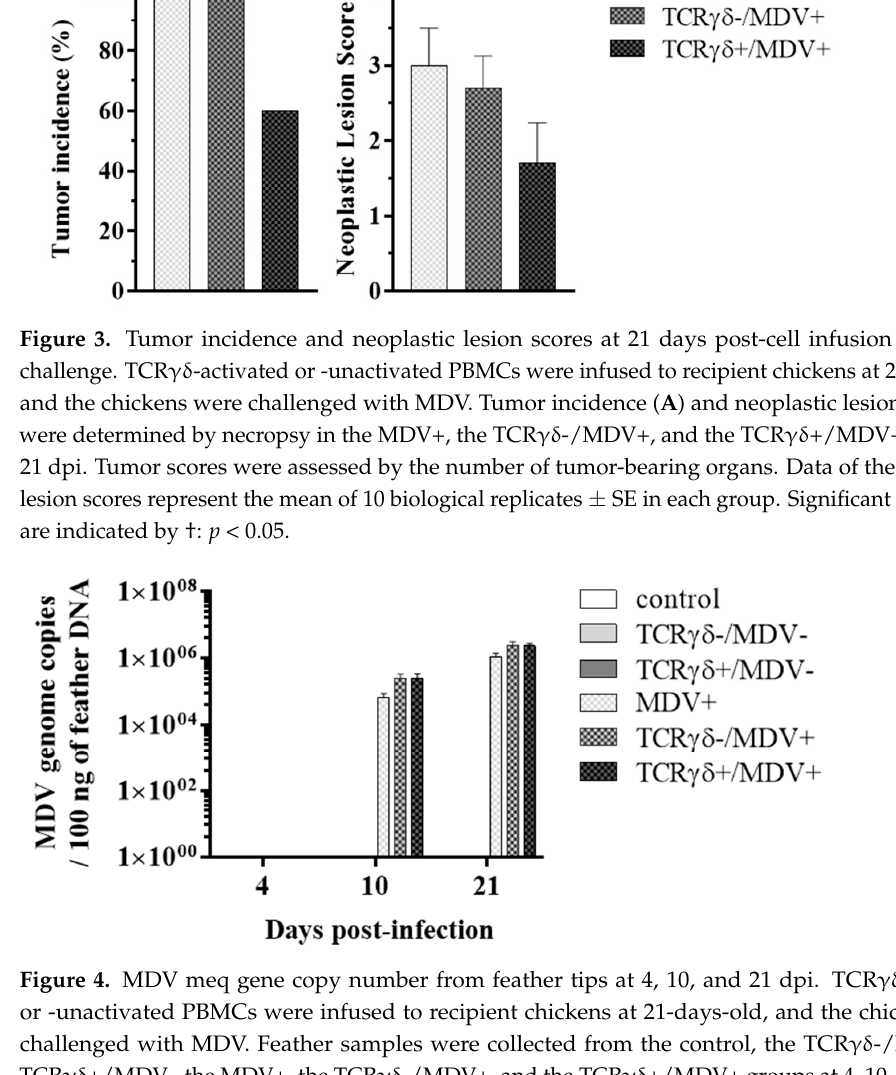
Figure 3. Tumor incidence and neoplastic lesion scores at 21 days post ‐ cell infusion and MDV chal ‐ lenge. TCR γδ‐ activated or ‐ unactivated PBMCs were infused to recipient chickens at 21 ‐ days ‐ old, and the chickens were challenged with MDV. Tumor incidence ( A ) and neoplastic lesion scores ( B ) were determined by necropsy in the MDV+, the TCR γδ‐ /MDV+, and the TCR γδ +/MDV+ groups at 21 dpi. Tumor scores were assessed by the number of tumor ‐ bearing organs. Data of the neoplastic lesion scores represent the mean of 10 biological replicates ± SE in each group. Significant differences are indicated by †: p < 0.05.